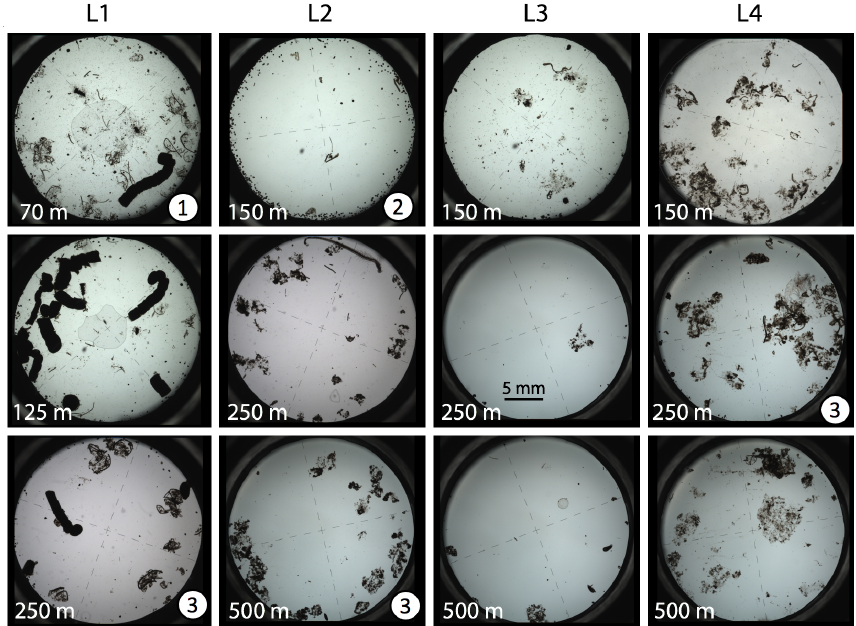
Figure 14. Representative transmitted light imagery of particles sampled by the CFEs at locations L1, L2, L3, and L4. The top row of images is for material captured shallower than ∼ 150m. The middle row shows particles captured near 250m (125m at L1). The bottom row are images of particles captured near 500m (250m at L1). Dashes in the images are 1mm long. Anchovy faecal pellets are the optically dense 7–10mm long particles seen in images at L1 (1). The 150m sample at L2 is ringed by several hundred ∼ 250µm sized olive faecal pellets (2). The > 1000µm sized aggregate particles dominate deeper samples at all locations and especially so at L4 (3). A closeup of olive-coloured faecal pellets and aggregates is in Fig. 6. All imagery is available